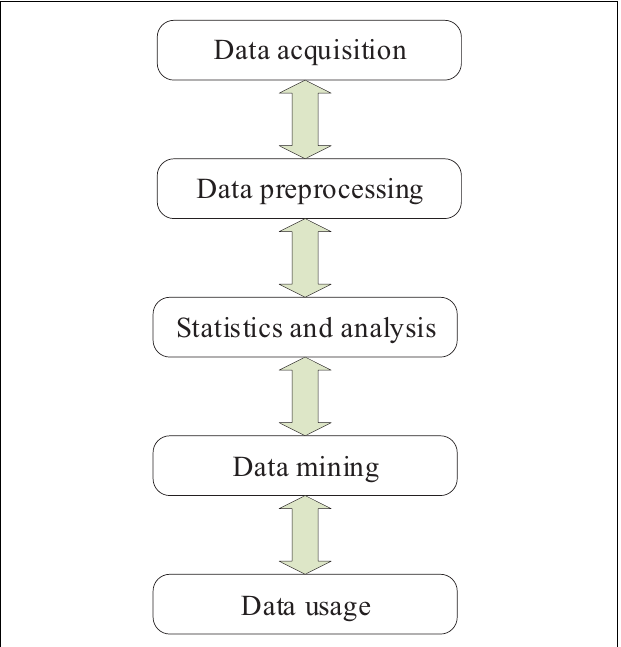
FIGURE 1 | Big data processing